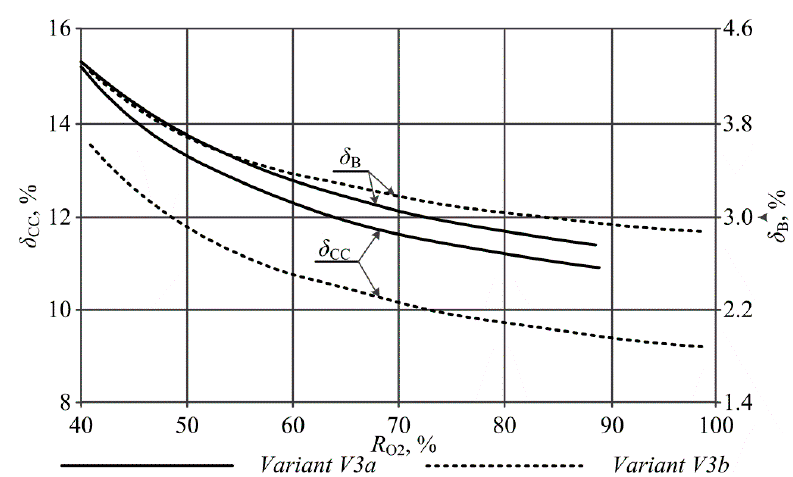
Figure 12. Auxiliary power rates of the boiler and the CC units as a function of the oxygen recovery rate.